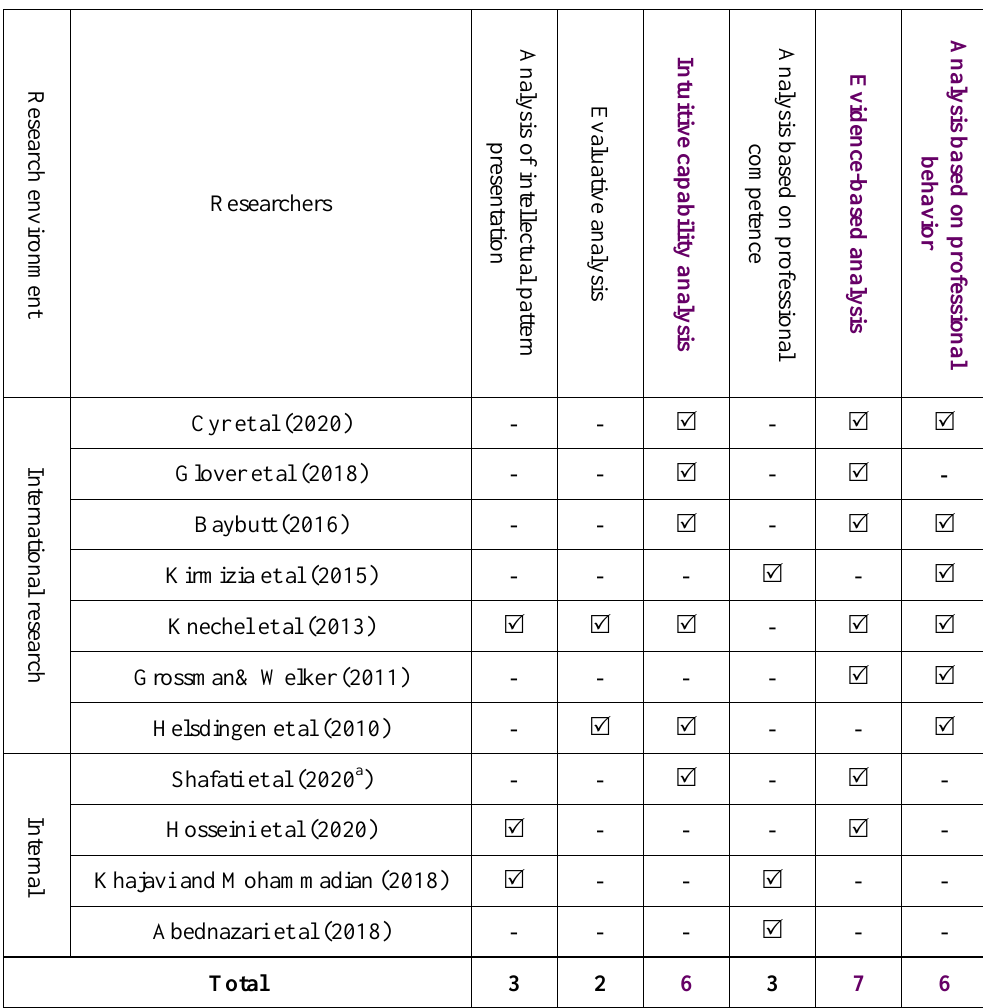
Table 2. the process of determining the main components of